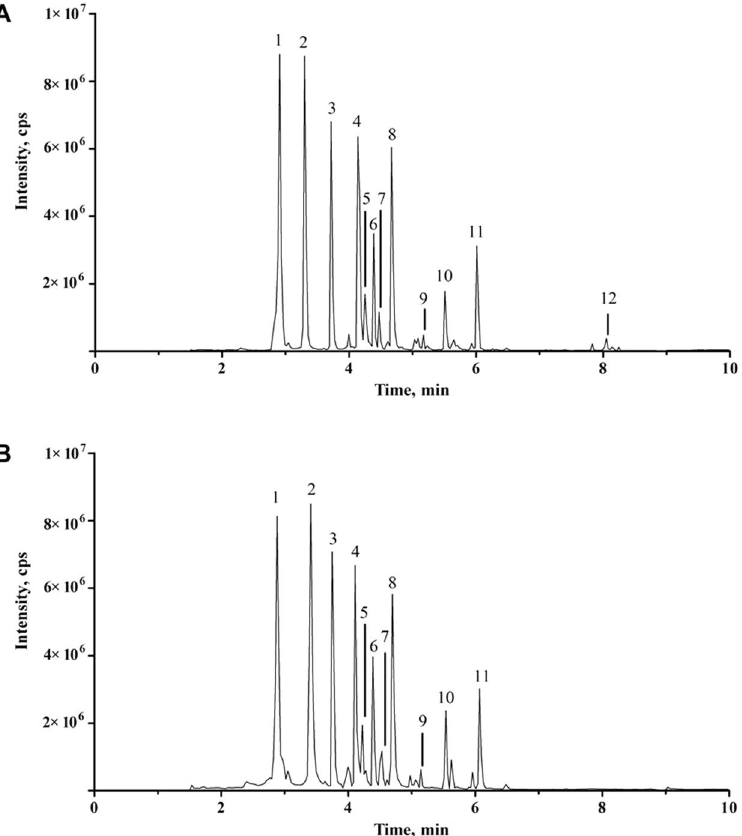
Figure 1. UFLC-MS chromatograms under MRM mode of predominant ingredients in QSYQ ( A ) and QSYQ-DO ( B ). Peak label: 1. Tanshinol, 2. Protocatechuic aldehyde, 3. Calycosin-7-O- β -D-glycoside, 4. Rosmarinic acid, 5. Ononin, 6. Salvianolic acid B, 7. Chloramphenicol (internal standard in negative mode), 8. Calycosin, 9. Astragaloside IV, 10. Formononetin, 11. Diazepam (internal standard in positive mode), and 12.